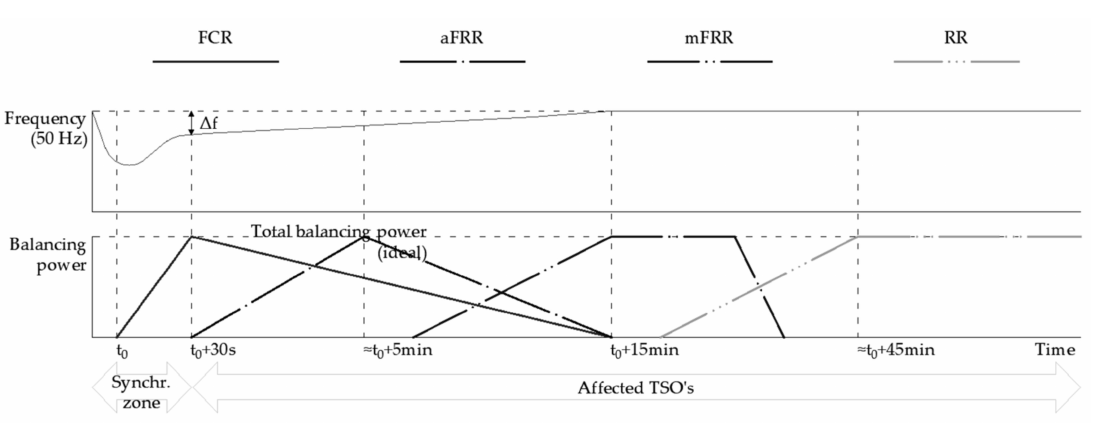
Figure 1. Chronology of frequency control process [9]. Table 2. Active power reserve volumes in Baltic power systems calculated in 2020 after synchroniza- tion with CESA [10]. Lithuania Latvia Estonia Baltic